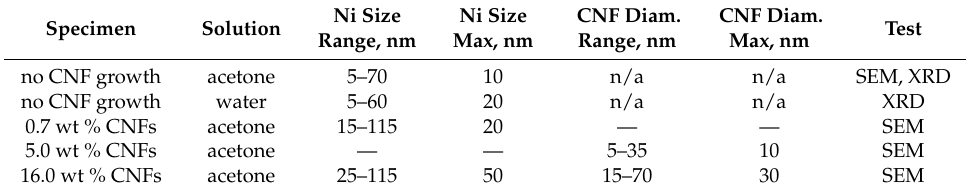
Table 1. Samples used for size measurements (range and maximum for Ni particles size or CNF diameters).